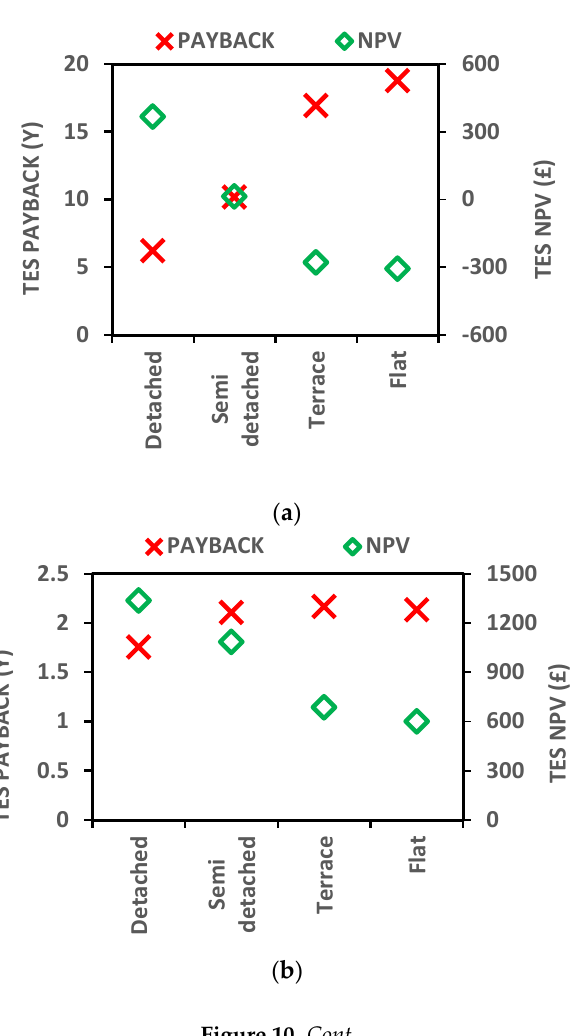
Figure 9. TES discharge profile for incentivised design: ( a ) detached house; ( b ) flat.